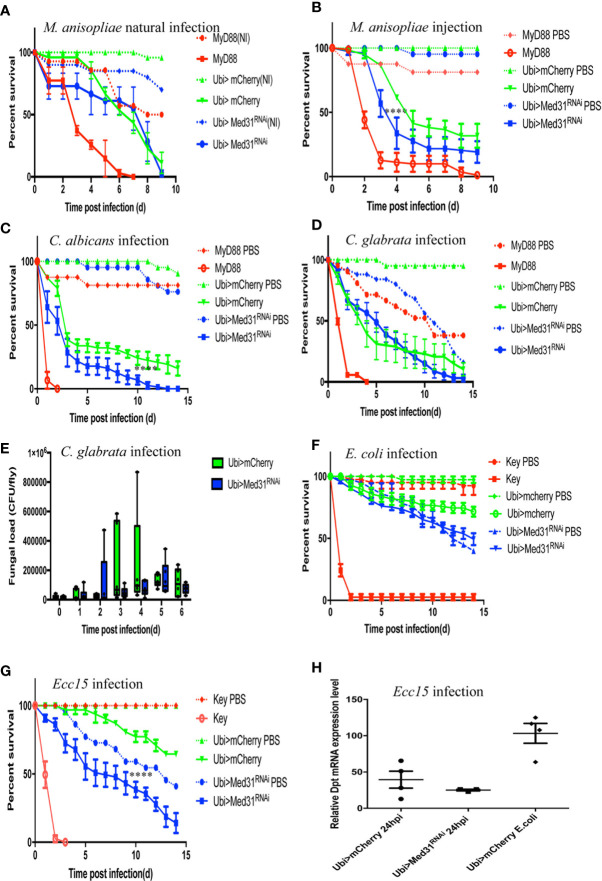
Susceptibility of Med31 RNAi flies to other pathogens. Survival of Med31 RNAi flies challenged with other pathogens. MyD88 represents the positive control line (red) for flies infected with M. anisopliae, C. albicans, C. glabrata, and E. faecalis; kenny, a member of the IMD pathway, is the positive control line (red) for fly lines infected with Ecc15 or E. coli, Ubi>mCherry RNAi line corresponds to the wild type control line (green) and Ubi>Med31 RNAi line (blue). For each infected line a PBS-injected control was also performed (dotted lines). (A) Survival of Med31 RNAi flies after M. robertsii natural infection. The survival curve is representative of nine independent experiments. (B) Survival of Med31 RNAi flies following M. robertsii conidia injection. Infected Med31 RNAi flies vs. infected mCherry RNAi flies: log-rank test, ****P < 0.0001. The survival curves are representative of five independent experiments. (C) Survival of Med31 RNAi flies following C. albicans infection. Infected Med31 RNAi flies vs. infected mCherry RNAi flies: log-rank test, ****P < 0.001. The survival curves are representative only of two out of four independent experiments, the other two not displaying any difference between Med31 RNAi and control flies. (D, E) Survival of Med31 RNAi flies and the fungal load following C. glabrata infection. The survival curves are representative of nine independent experiments. (F) Survival of Med31 RNAi flies following E. coli infection. The survival curves are representative of two independent experiments. (G) Survival of Med31 RNAi flies after Ecc15 challenge. The survival curves are representative of nine experiments. (H)
Diptericin expression level normalized to the Rpl32 house keeping gene at 24 h post infection with Ecc15. Each dot represents one sample containing four flies. Septic infection with E.coli was a positive control for Diptericin expression. Mean ± SEM are indicated, except for 3E where the median is displayed.